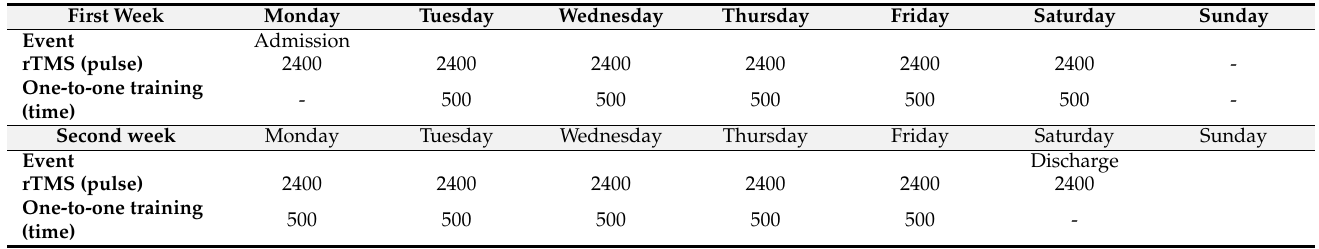
Table 2. NEURO ® study protocol and momentum